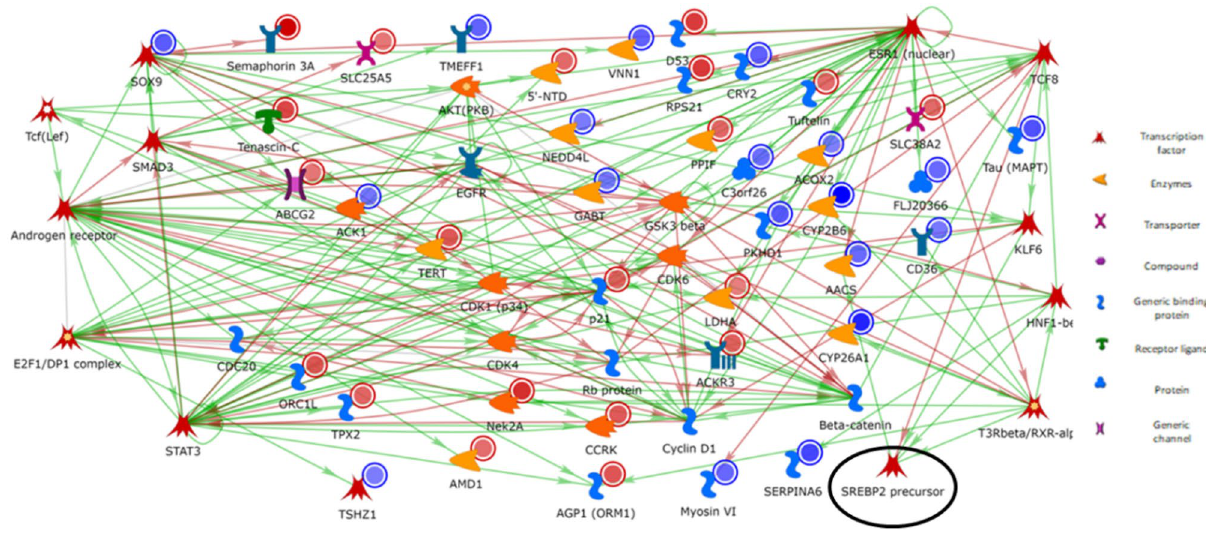
Figure 1. The network was created with MetaCore basic analysis networks (transcription factor) algorithm using DEG list (FDR < 0.1) from liver tissue of immunocastrated male pigs fed diets containing different levels of soybean oil (SOY1.5: 1.5% and SOY3.0: 3.0% soybean oil). The green lines represent the activation of other genes, whereas the red lines represent an inactivation. In the blue circles, genes down-regulated and up-regulated are highlighted with red circles. The SREBP2 precursor is highlighted with a black circle. Image created by MetaCore (Clarivate Analytics) [https:// portal. genego.